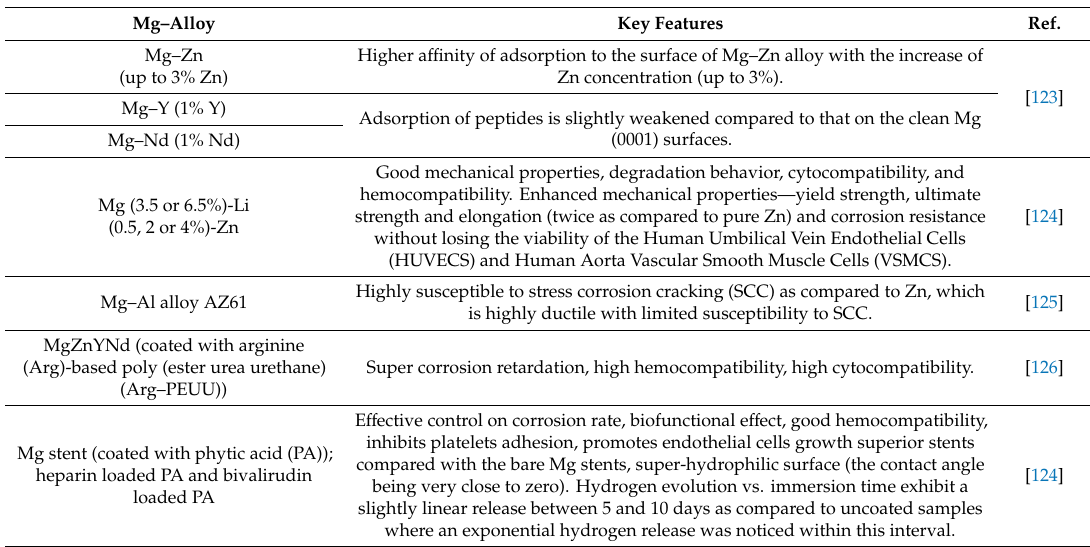
Table 1. Mg alloys used for stent